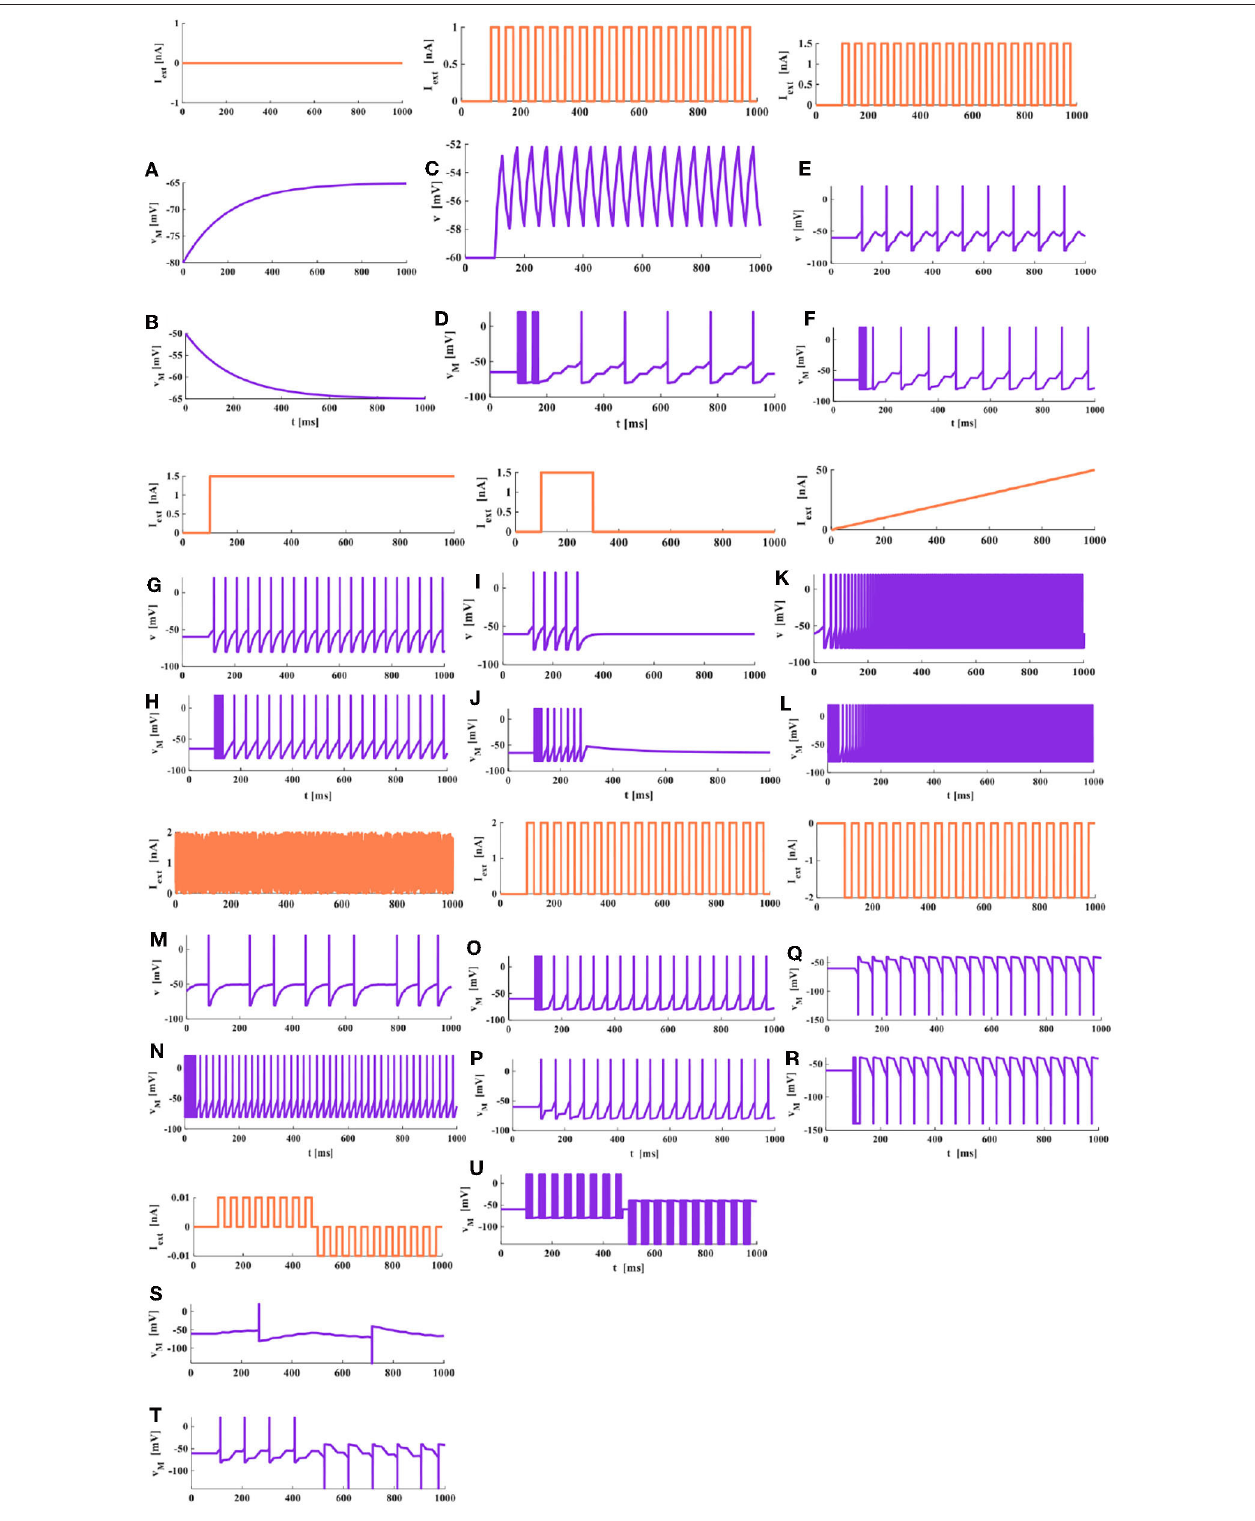
FIGURE 4 | The relationship between the external stimulus and the action potential (the threshold voltage is and the reset potential is 80 mV). (A) The initial potential is −